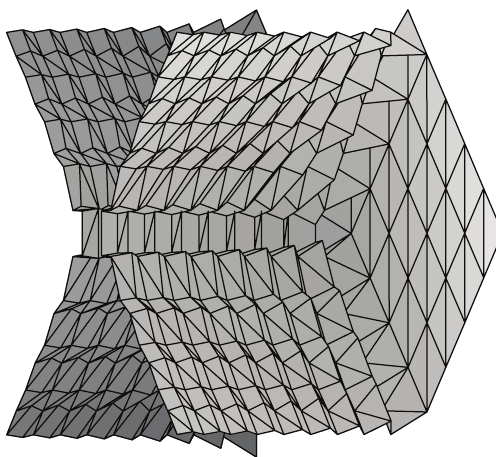
Figure 5: The surface shows the exact solution u (cid:3) t,x,y (cid:4) for (cid:3) 3.11 (cid:4) .